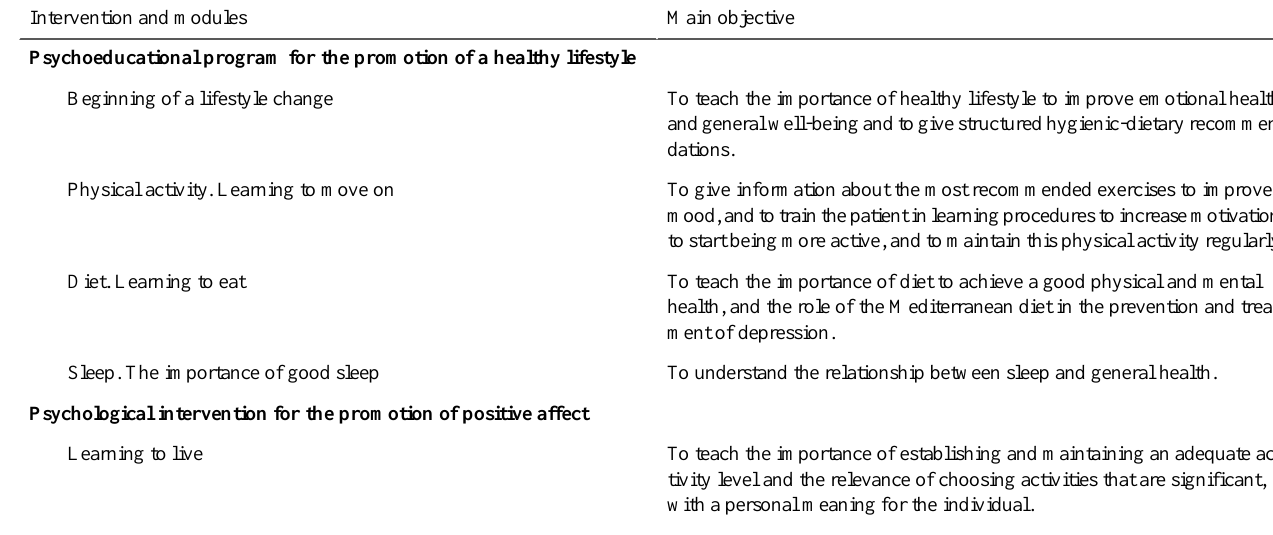
Table 1. Intervention modules and main